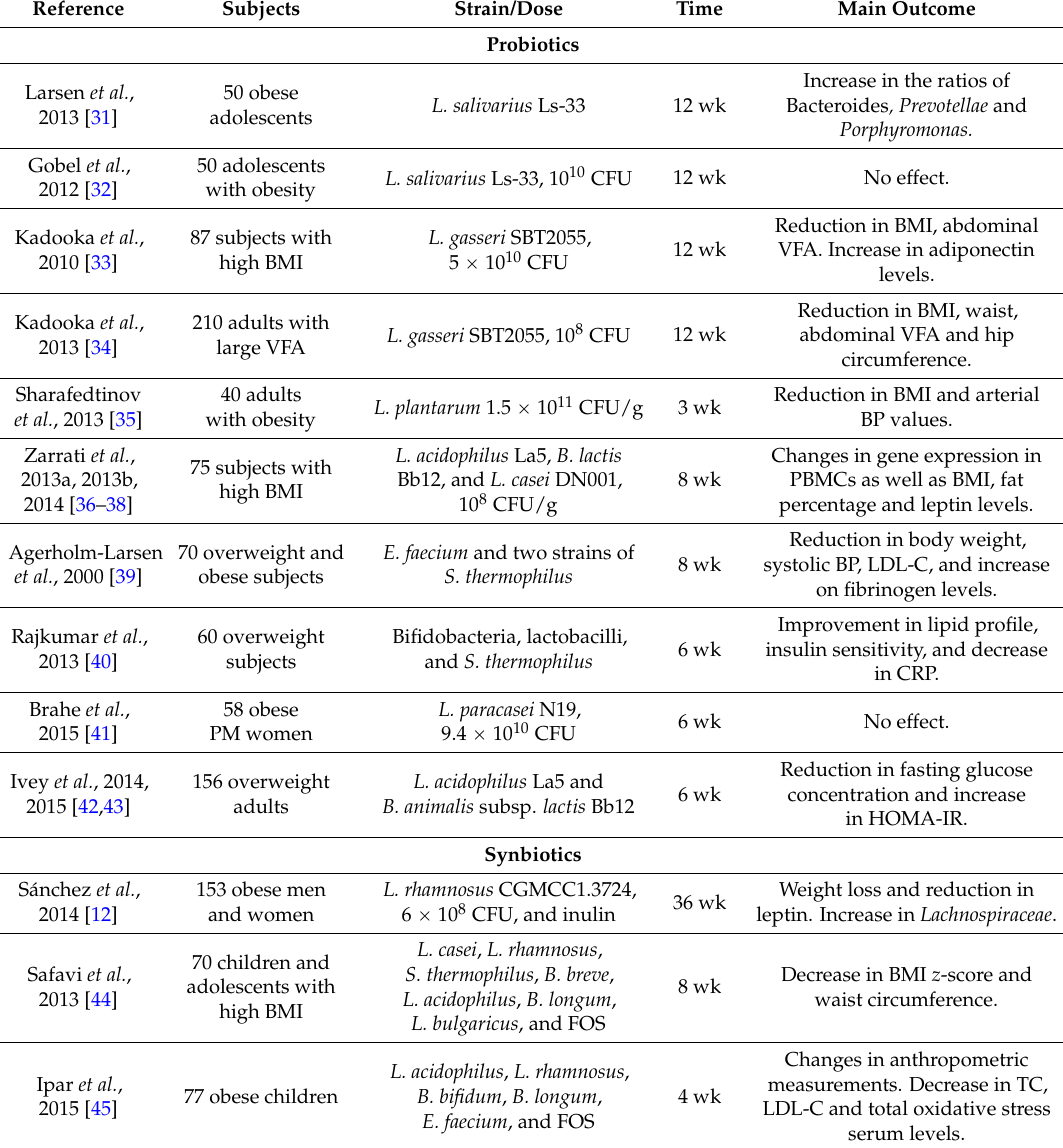
Table 1. Summary of randomized clinical intervention trials of probiotics and synbiotics in